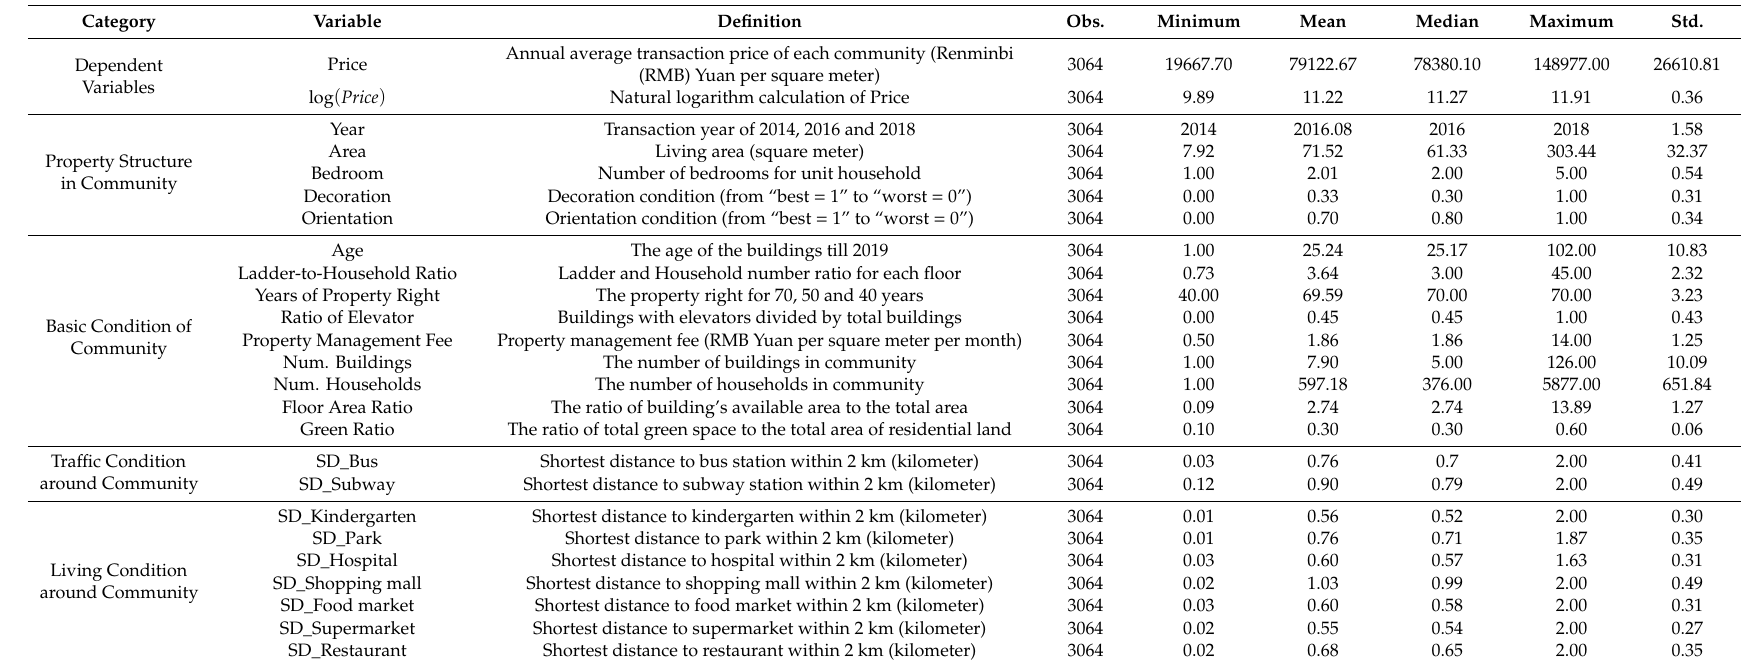
Table 2. Summary of